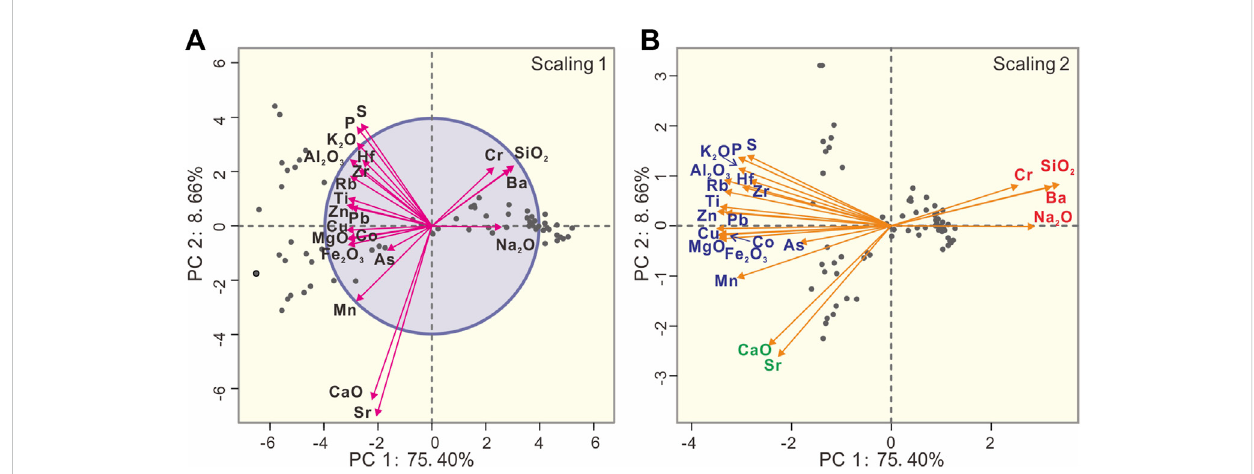
Principal component analysis of element concentration data of the paleo-oxbow lake fi ll at NYQ-B site within the Zoige Basin on the NE Tibetan Plateau. Elemental projections over the distance biplot using scaling 1 (A) and over the correlation biplot using scaling 2 (B) onto the fi rst two principal components (PC1 and